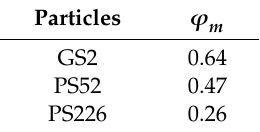
Table 2. Maximum packing fraction ( ϕ m ) of all suspensions in glycerol as obtained from the Quemada fittings to the infinite shear rate relative viscosities, η r , ∞ .